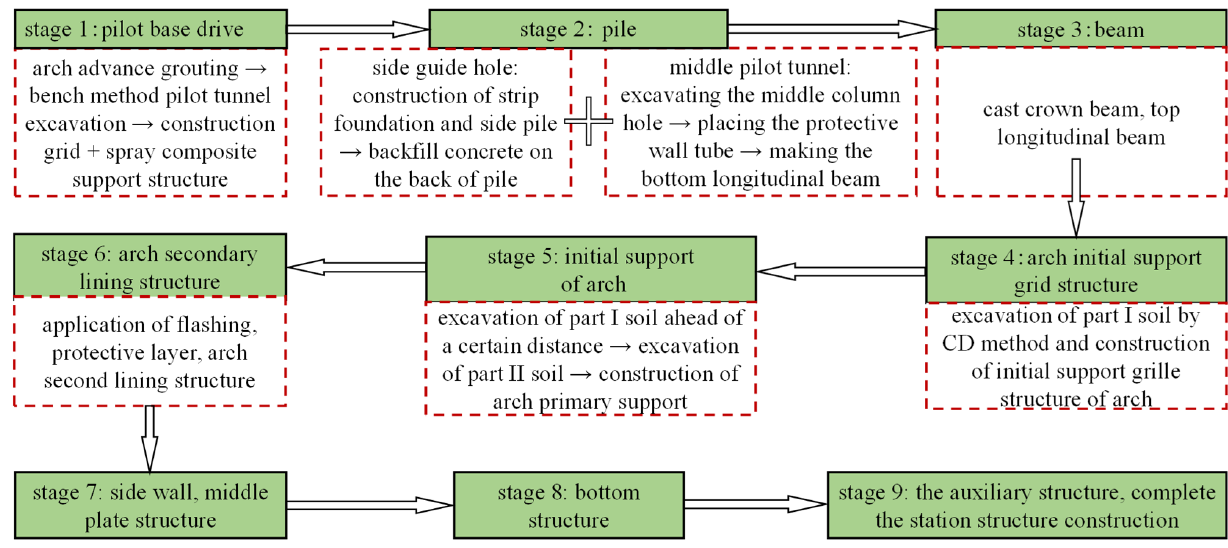
Figure 4. Construction procedure of PBA method.